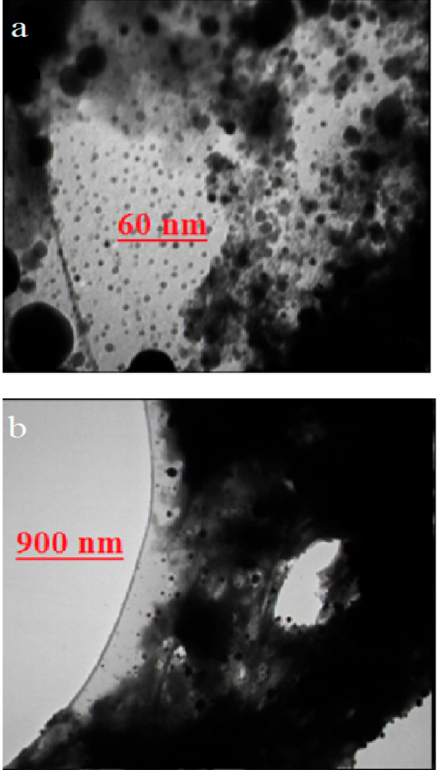
Figure 12. TEM images from different angles of PIL(low)@TiO 2 @m-GO after the photocatalytic reaction, ( a ) 60nm magnification; ( b ) 900nm